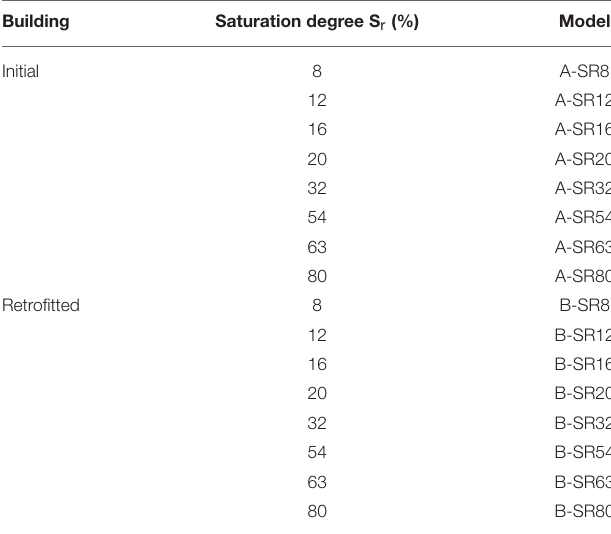
TABLE 4 | List of abbreviations for the examined